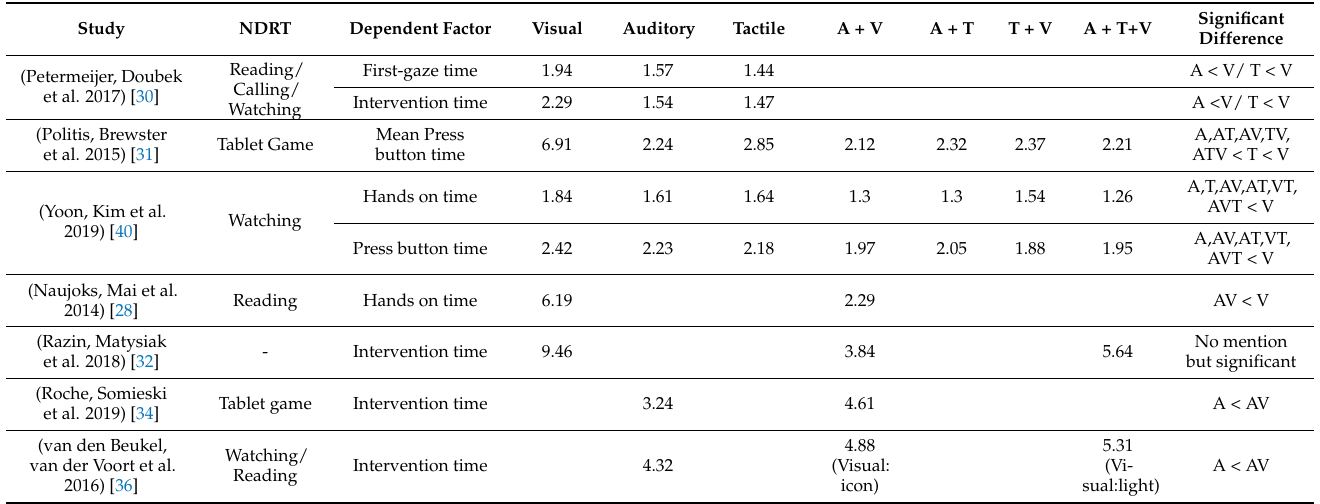
Table 3. Take-over time of modality studies (times are given in